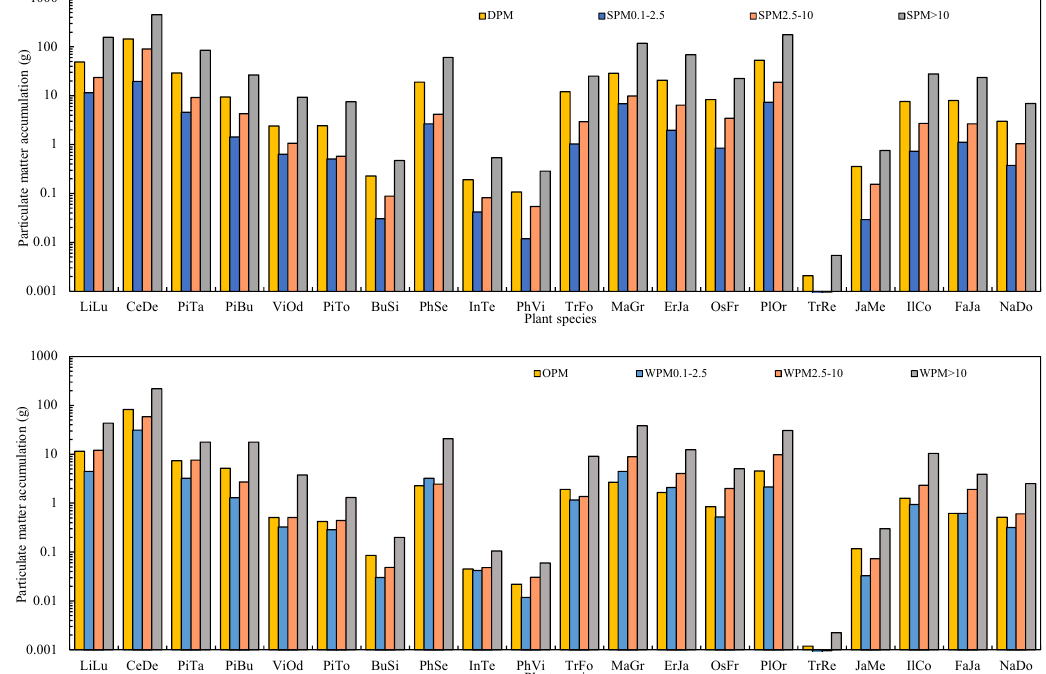
Figure 4. The mass of PM per tree eluted by water and brushing (SPM), chloroform and brushing (WPM) within different diameter classes (diameter > 10 µ m, 2.5–10 µ m, 0.1–2.5 µ m), water-soluble (DPM), and organic-soluble (OPM) particulate matter retained on the investigated leaves.